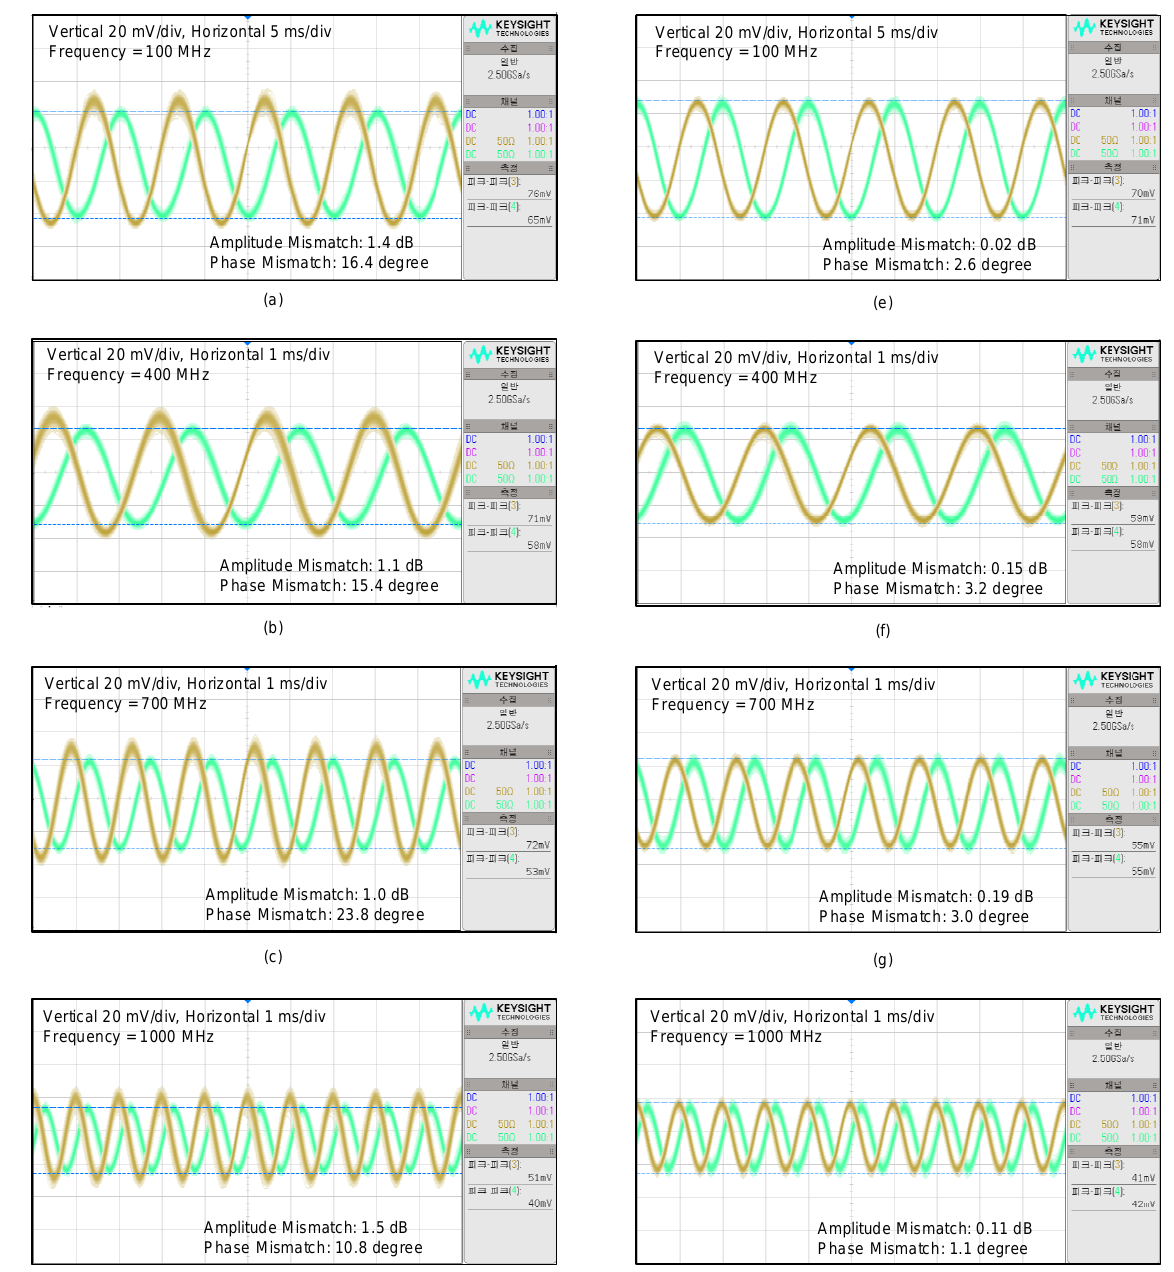
Figure 13. Measured I/Q baseband waveforms before and after calibration. ( a ) 100 MHz before calibration; ( b ) 400 MHz before calibration; ( c ) 700 MHz before calibration; ( d ) 1000 MHz before calibration; ( e ) 100 MHz after calibration; ( f ) 400 MHz after calibration; ( g ) 700 MHz after calibration; ( h ) 1000 MHz after calibration.